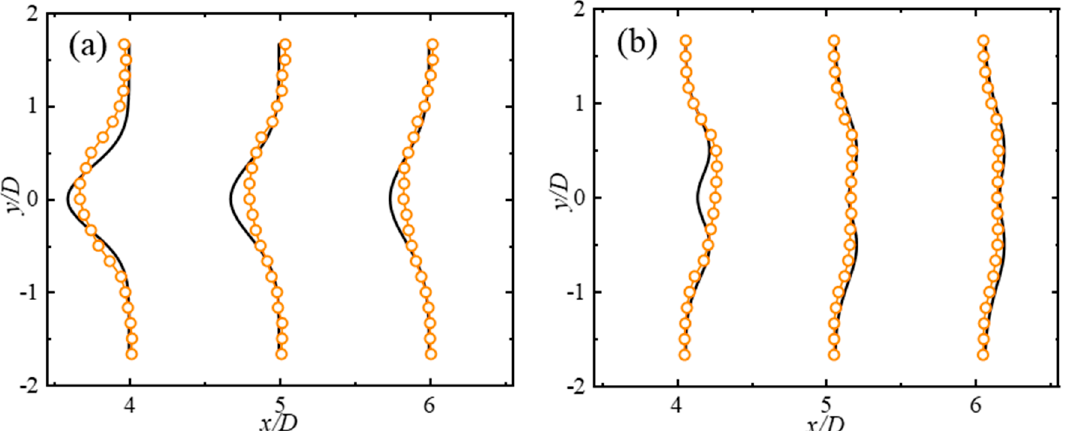
Figure 7. Wake characteristics of the thrust-optimized model and the Gaussian wake model at hub height (Gaussian wake model—black solid lines; thrust-optimized model—orange dotted lines). ( a ) Normalized mean velocity profile; ( b ) turbulence intensity profile.